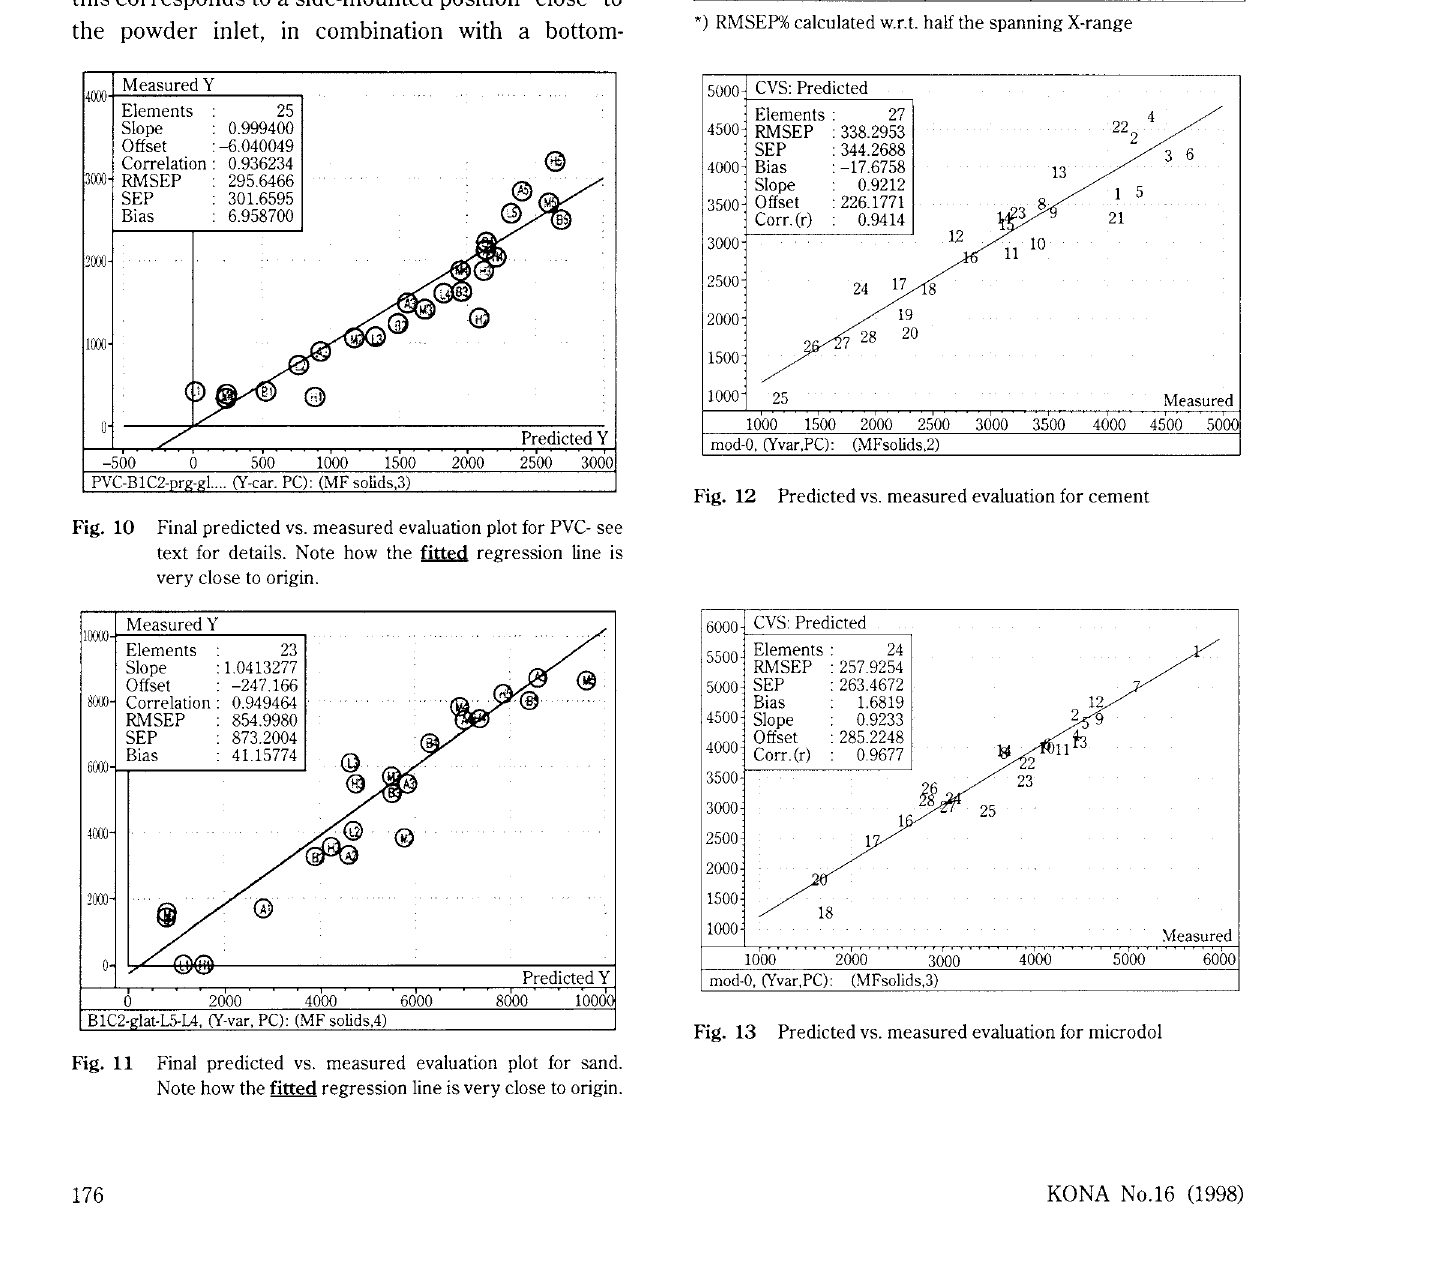
Fig. 11 Final predicted vs. measured evaluation plot for sand. Note how the fitted regression line is very close to origin.